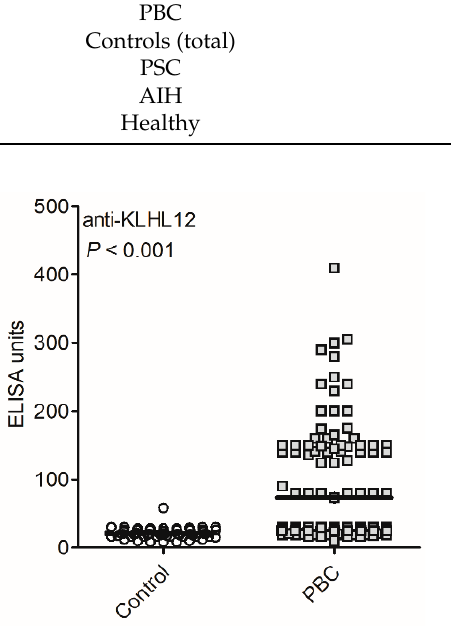
Figure 4. Anti-KLHL12 autoantibodies in sera of PBC patients.